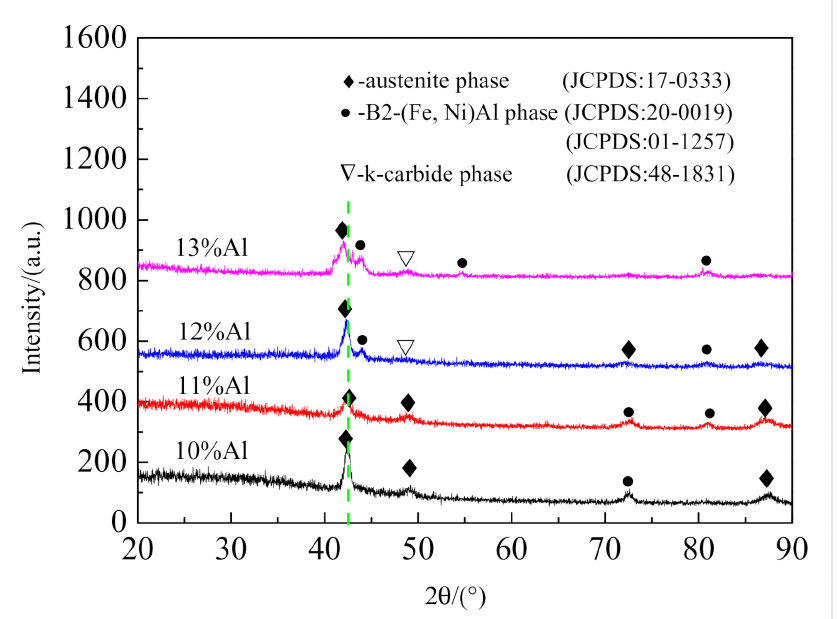
Figure 2. XRD diffraction pattern of Fe-25Mn- x Al-8Ni-C